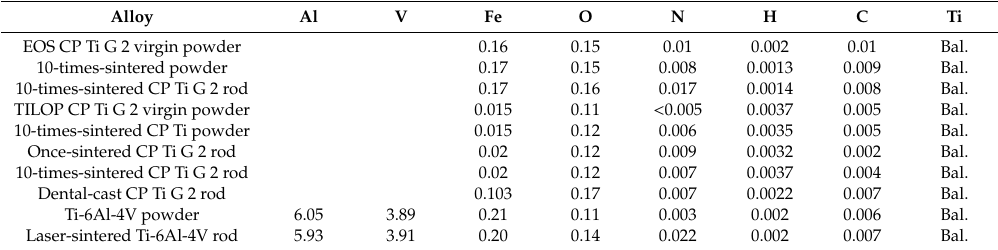
Table 1. Chemical compositions (mass %) of CP Ti G 2 virgin powders, laser-sintered CP Ti G 2 and Ti-6Al-4V alloy, and dental-cast CP Ti G 2 rods. Alloy Al V Fe O